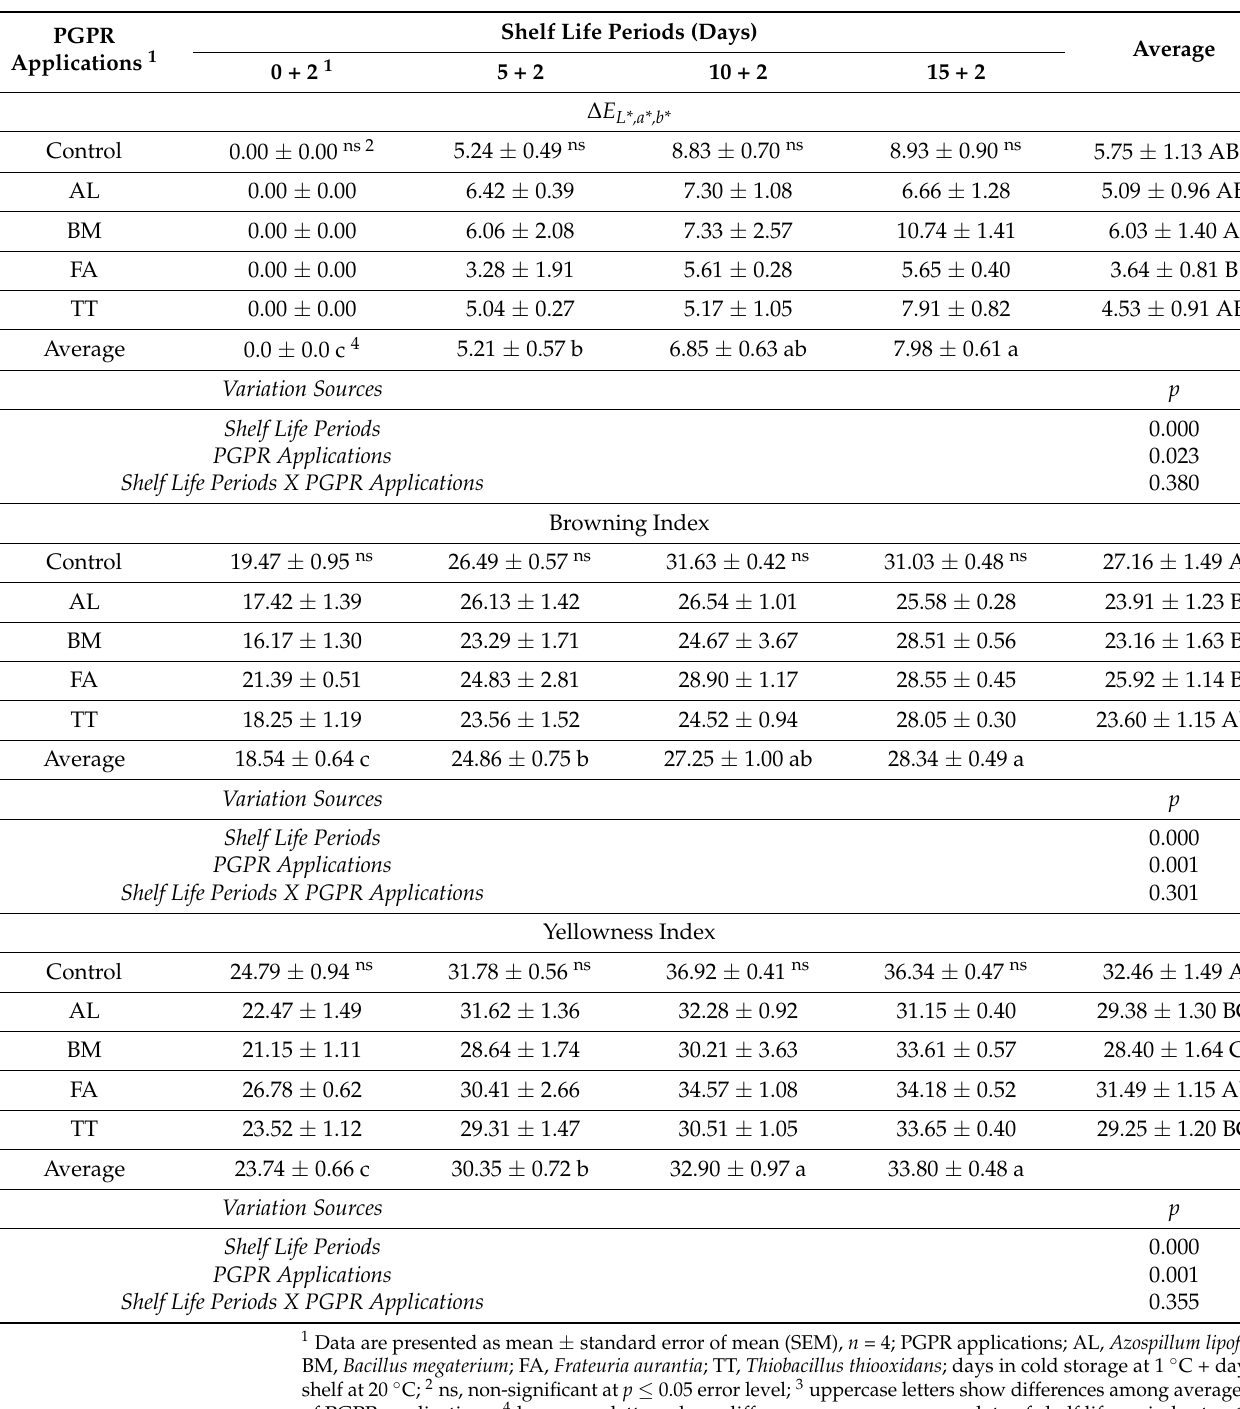
Table 3. The effect of different PGPR applications on color changes in white button mushroom during shelf life